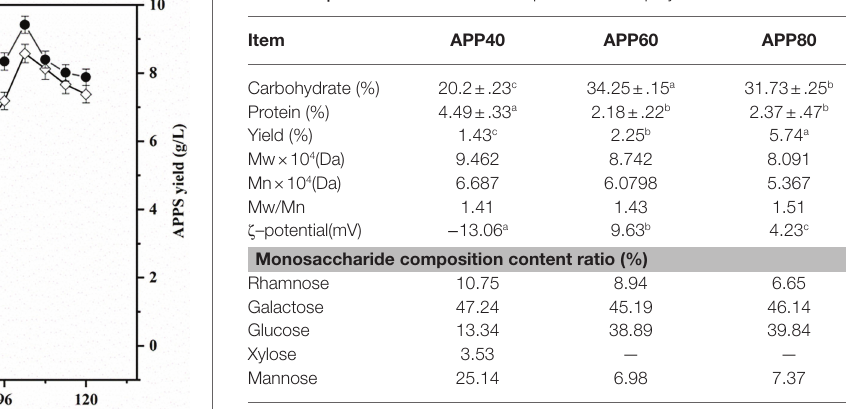
TABLE 2 | Characterization and composition of the